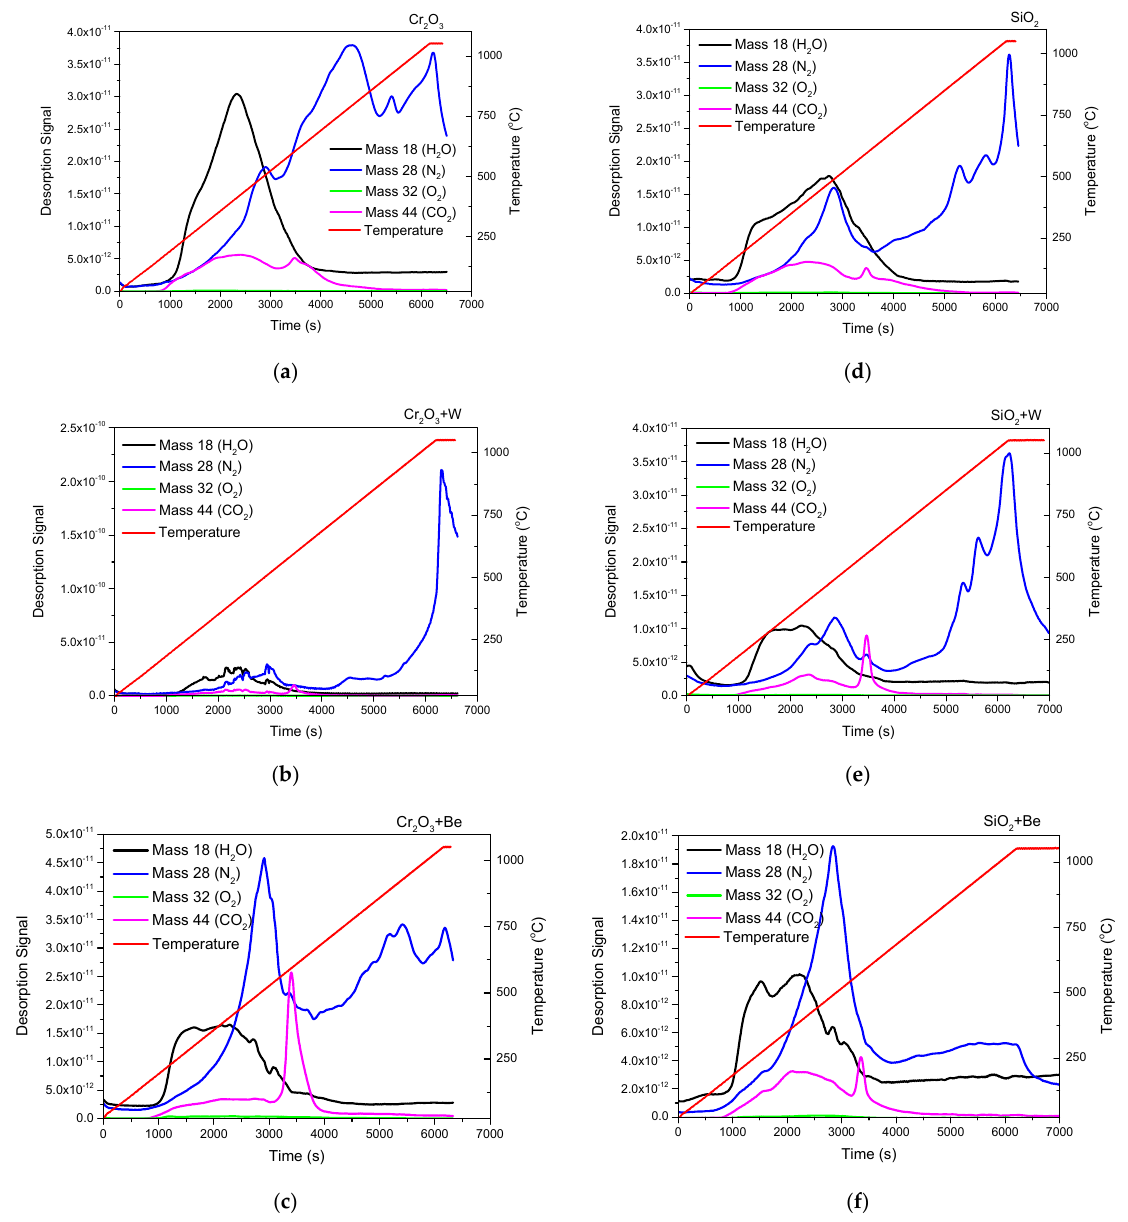
Figure 6. H 2 O, N 2 , O 2 , and CO 2 desorption profiles as a function of time and at a heating rate of 10 °C/min, acquired for the following samples: A1 ( a ), A2 ( b ), A3 ( c ), B1 ( d ), B2 ( e ), and B3 ( f ).